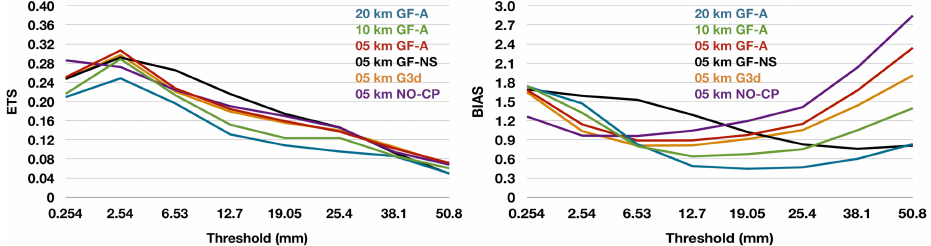
Figure 12: As in Figure except for Root Mean Square Error (RMSE) and mean error (Bias). Units are mm/6hr shows a comparison of the commonly used Equitable Threat Scores (ETS) and the commonly used BIAS scores of the 24-h accumulated rainfall for the six simulations and averaged over the 15 days. The BIAS score measures the ratio of the frequency of forecast events to the frequency of observed events, binned by certain thresholds. It does not measure how well the forecast corresponds to the observations. It is also not related to the Bias calculated in Figure 12. A perfect model would obtain a value of 1 for both ETS and BIAS scores for any threshold. First we notice commonly seen BIAS scores that are too large for all approaches for the low thresholds. Additionally, for large thresholds – there are of course less cases available – BIAS scores become much larger with increasing importance of resolved physics. A more detailed look reveals that for the thresholds from 0.254 to 25.4 mm, GF-A and G3d on 5km have the best BIAS scores, followed by GF-A on 10km and 20km resolution. For the high thresholds (above 38.1 mm), coarser resolutions as well as GF-NS have better scores, but the statistical significance may be limited by the low number of cases. The number of cases for each bin are given in table 2. When comparing the ETS scores, we first note that GF-NS has the highest scores for thresholds bins of 6.5 and 12.7 mm, probably as a result of the over-forecast of events